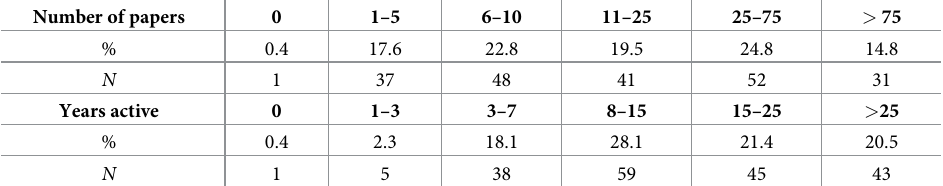
Table 1. The number of papers published and years active in animal cognition of the 210 researchers completing the survey. Number of